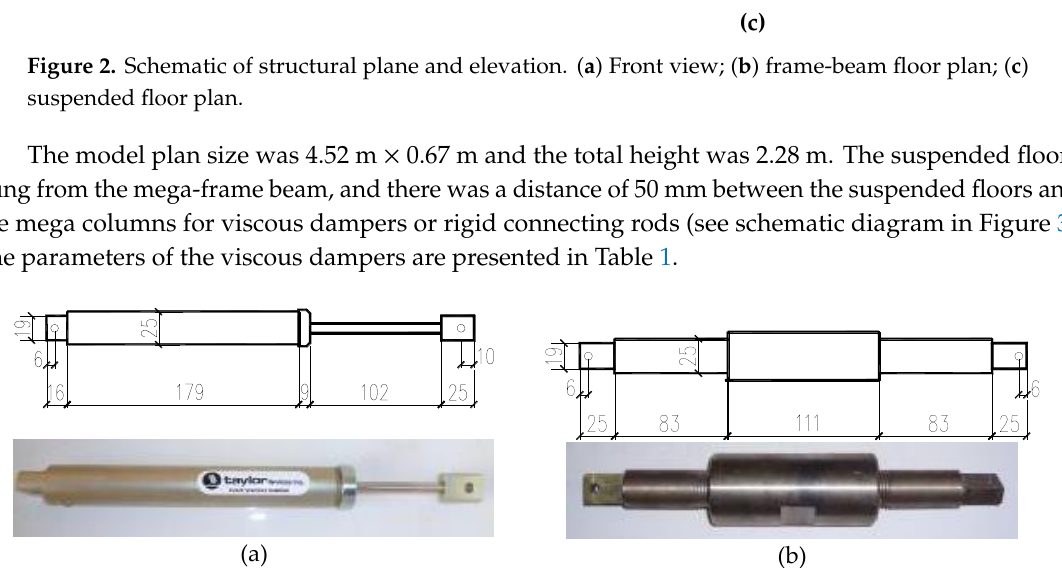
Figure 3. Schematic diagrams of two types of connection. ( a ) Viscous damper; ( b ) rigid connecting rod. Table 1. Parameters of viscous dampers.